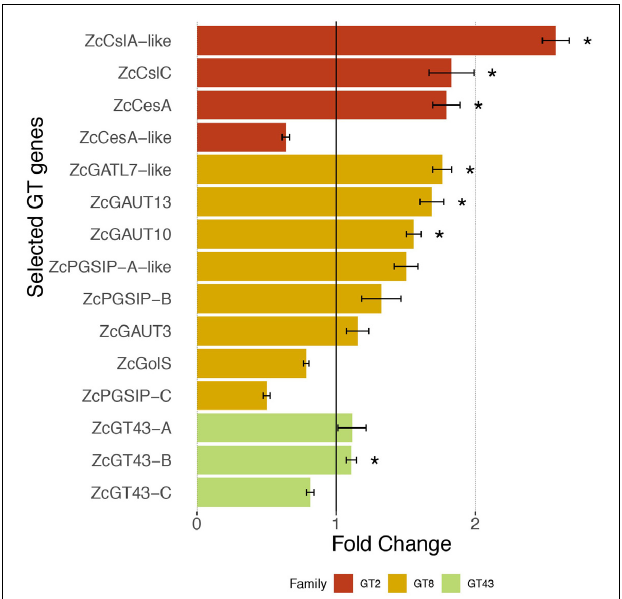
FIGURE 4 | Expression response of 15 selected GT genes toward osmotic stress. Quantitative RT-PCR measures the relative expression in fold change (average ± SE, n = 6) in UTEX 1559 after 1 h of 300 mM Sorbitol treatment vs. no treatment (control). Significant p -values ( < 0.05) from t -tests were shown as ∗ to indicate that the Sorbitol treatment samples were significantly higher than control samples in terms of